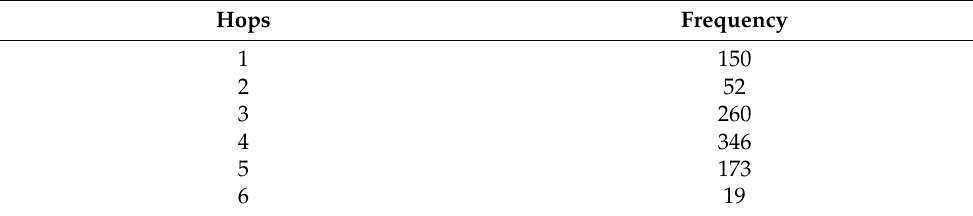
Table 2. The statistic result of experiment